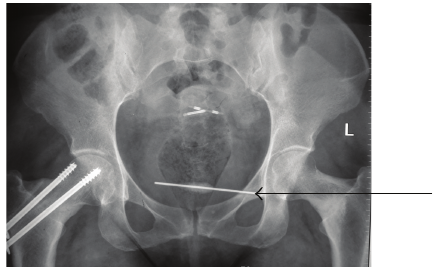
Figure 1: Photograph of the X-ray of pelvis showing the K-wire in the pelvis. A previously inserted copper-T in the uterus is also seen.